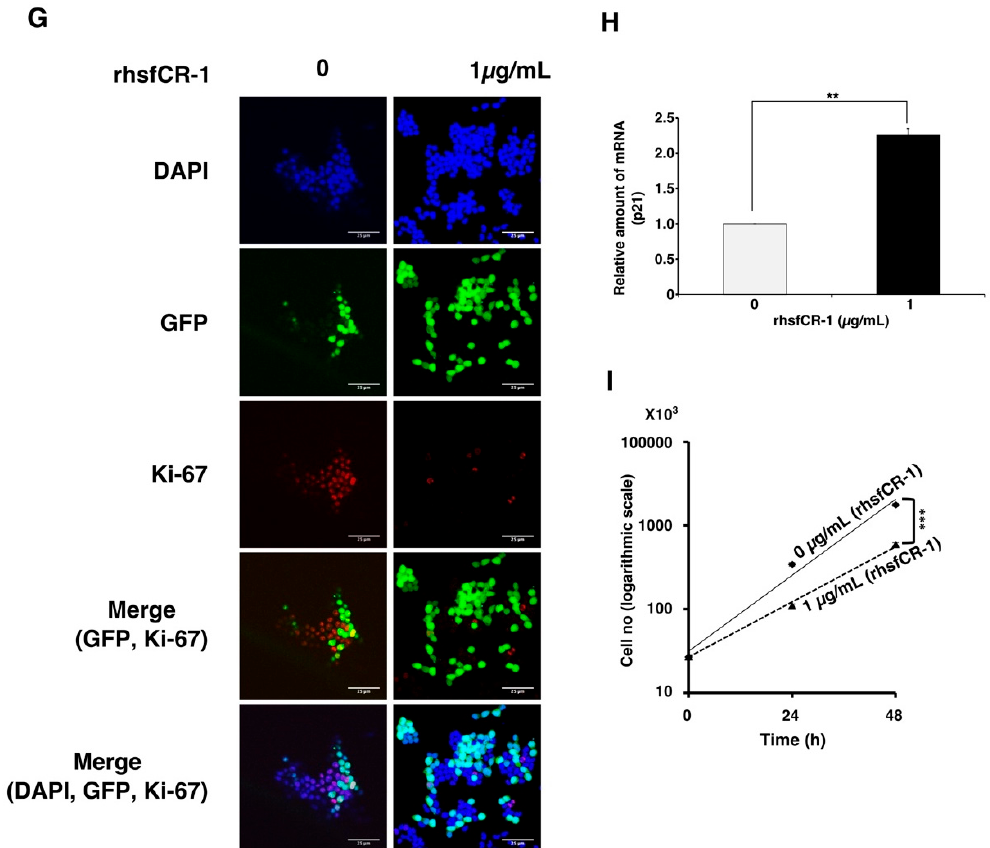
Figure 2. Evaluation of the suppression of growth in miPS-LLCcm cells by rhsfCR-1. ( A ) miPS-LLCcm cells were treated for 48 h with/without rhsfCR-1 (1 µg/mL) and photographed under adherent condition; ( B ) miPS-LLCcm viability were assessed by MTT assay after 24 h treatment with different concentrations of rhsfCR-1. Experiments were repeated three times and the data were plotted as the mean ± SD ( n = 3); ( C ) live cells were counted after 24 h treatment with either 0.5 µg/mL and 1 µg/mL rhsfCR-1; ( D ) rhsfCR-1 did not induce apoptosis of miPS-LLCcm cells. Apoptosis was assessed after 24 h of treatment with rhsfCR-1 by flow cytometry with double staining with PI and APC-Annexin-V; ( E ) no significant changes in the number of apoptotic cells were found between the treatments with/without rhsfCR-1. Bar plots represent the percentage of apoptotic cells in ( D ); ( F ) rhsfCR-1 did not affect on the cell cycle of miPS-LLC cells. Cells treated with/without rhsfCR-1 were stained with PI and analyzed by flow cytometry; ( G ) confocal observation of immunostaining of miPS-LLCcm cells with anti-Ki-67 antibody together with GFP and DAPI staining; ( H ) rt-qPCR analysis of p21 expression in miPS-LLCcm cells treated with/without rhsfCR-1; ( I ) rhsfCR-1 suppressed the growth of the miPS-LLCcm cells during the time course up to 48 h. Live cells were counted after 24 and 48 h treatments with/without rhsfCR-1. Each bar represents mean ± SD from three independent plates. One-way ANOVA with pairwise multiple comparisons ( C ), Student’s t -test ( H ) and Two-way ANOVA ( I ) were used to analyze the level of significance (** p < 0.01, *** p < 0.001).